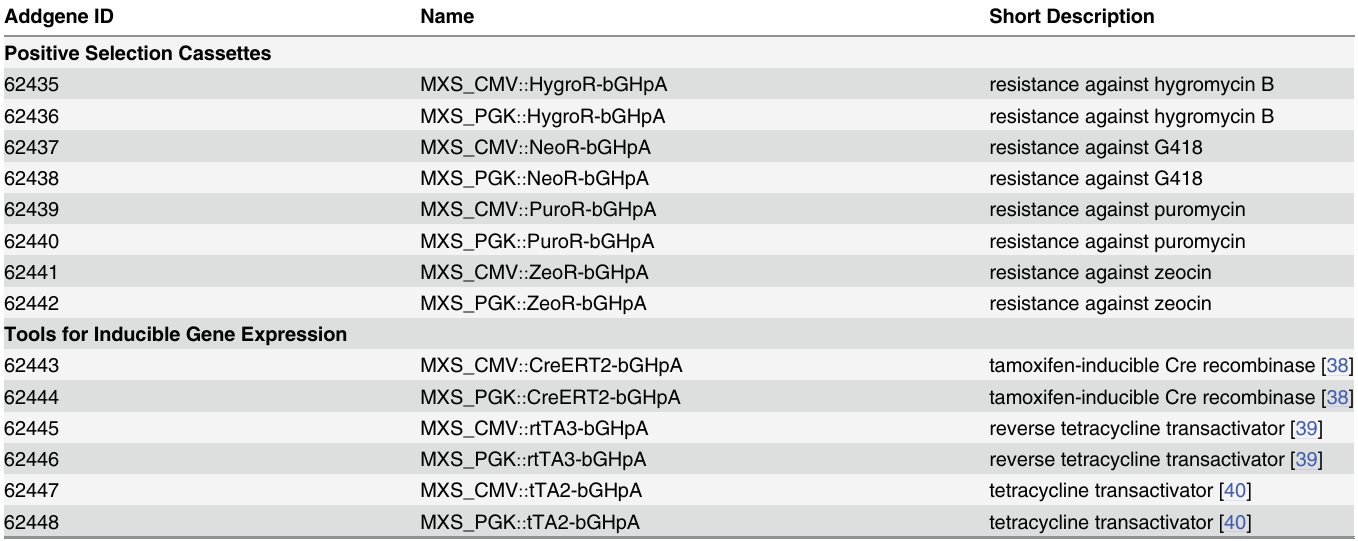
Table 3. MXS-cassettes available from Addgene.